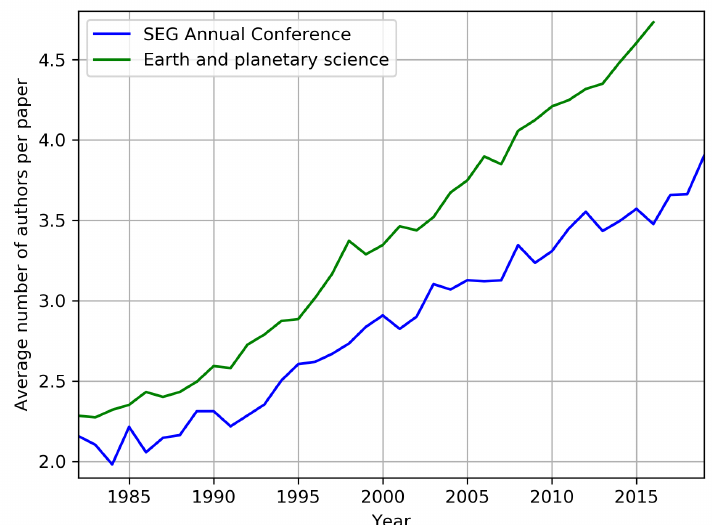
Figure 4. Growth rate of the number of co-authors for the SEG Annual Conferences and the Earth and Planetary science